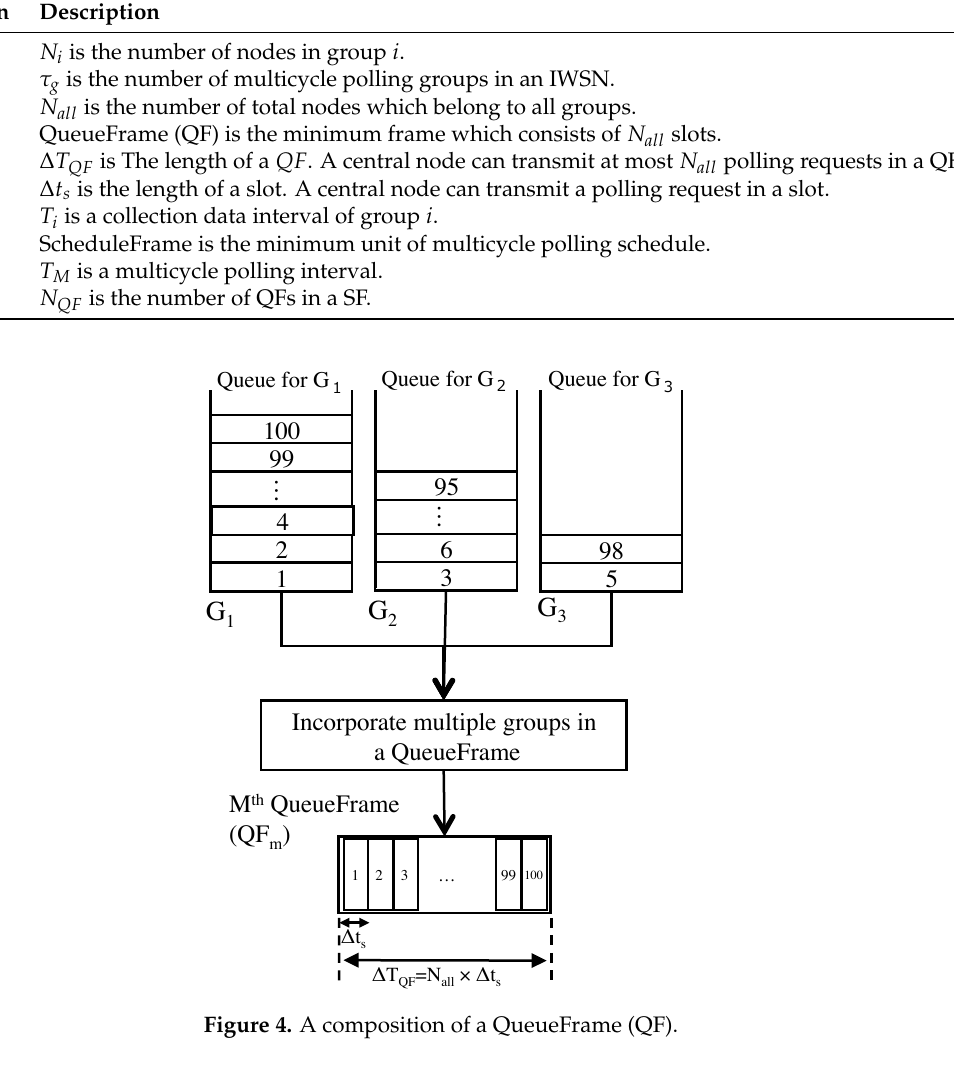
Table 2. Notation and description.